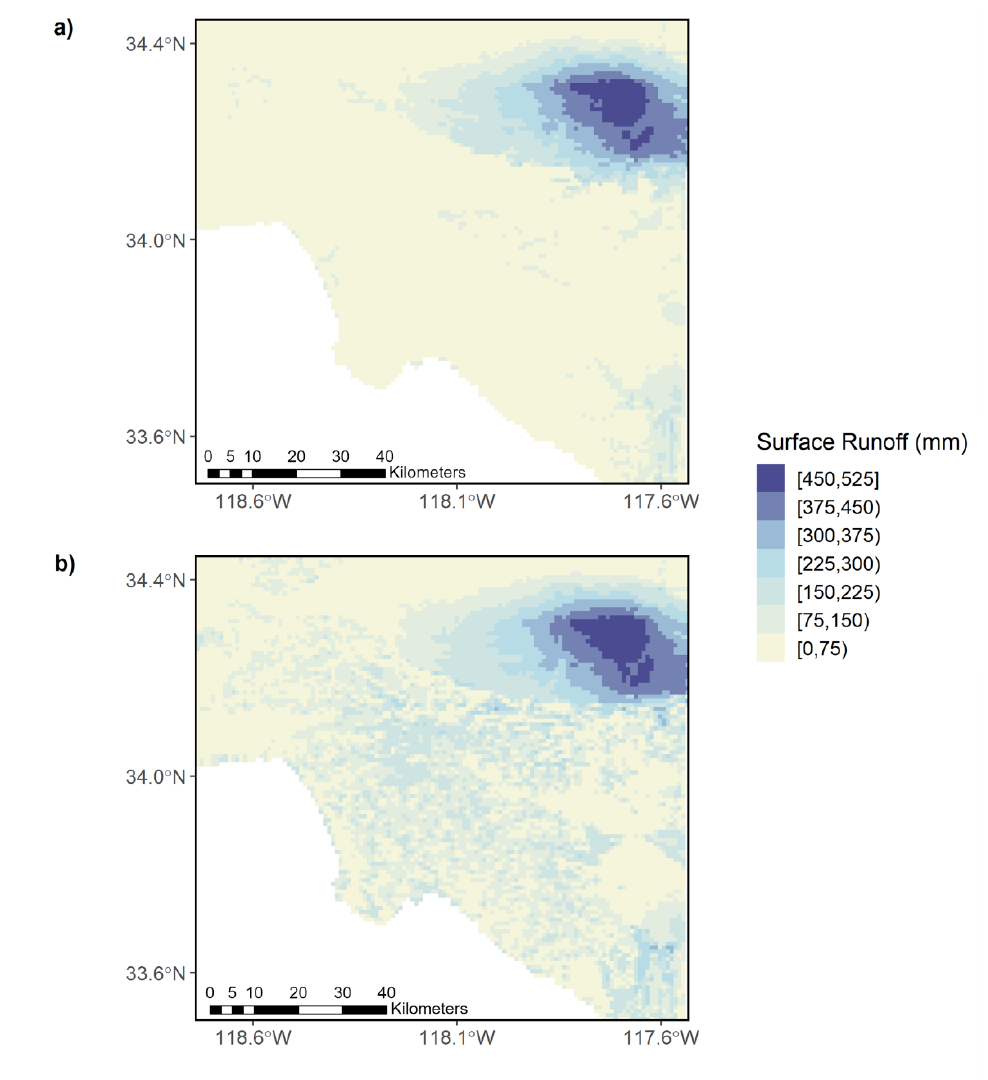
Figure 9. Accumulated surface runoff in the LA metropolitan area over the December 2010 precipi- tation event for ( a ) the pre-urban development scenario without impervious surfaces and ( b ) the post-urban development scenario under present imperviousness conditions.